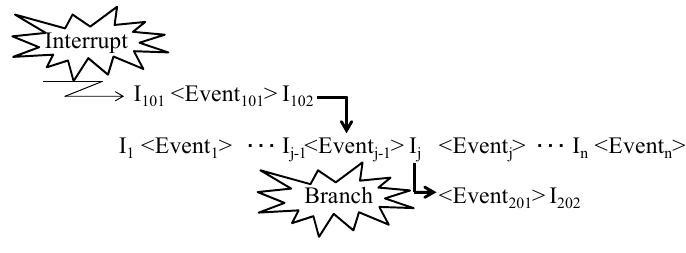
Figure 1. Example of an execution process.